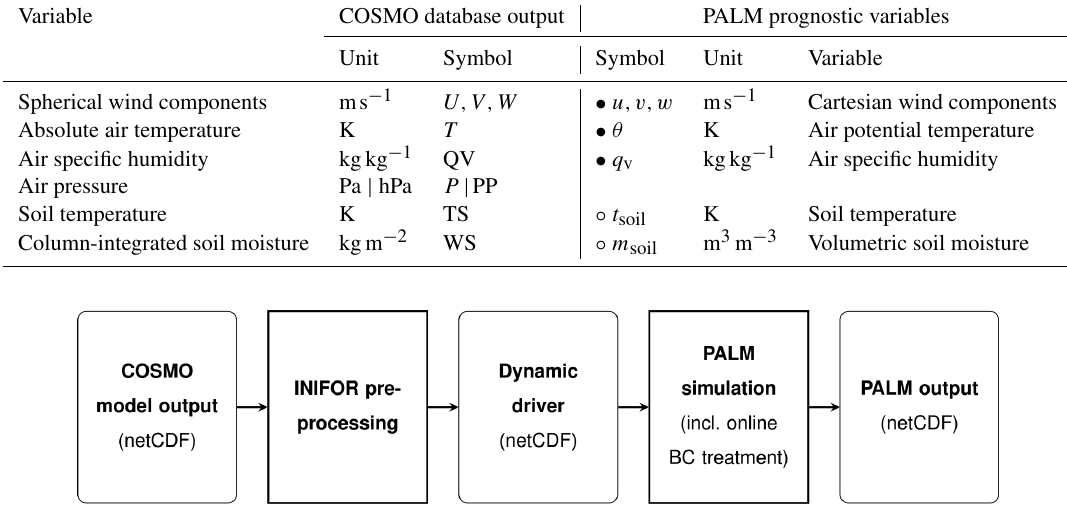
Figure 1. Simulation workflow using PALM’s mesoscale nesting